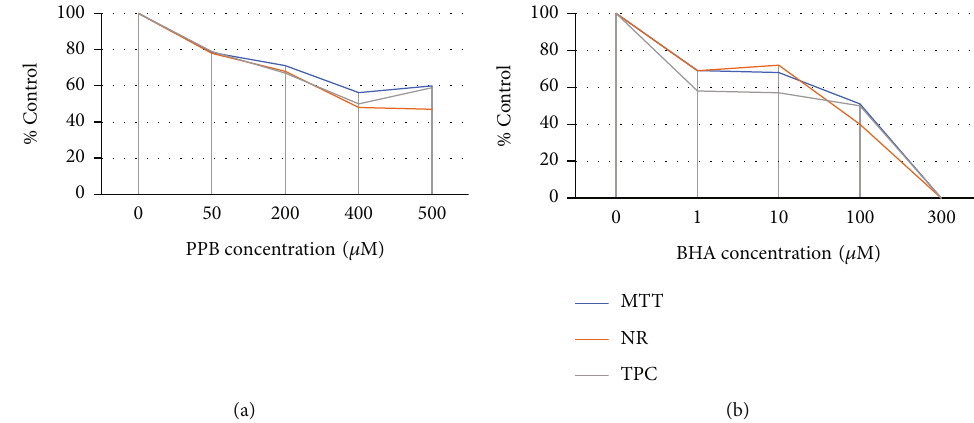
Figure 3: MTT reduction tests, neutral red capture, and TPC after 24 hours of exposure to binary mixtures of BHA and PPB. (a) Binary pools are composed of 100 μ M BHA and a range of PPB concentrations (50-500 μ M). (b) Binary pools are composed of 500 μ M PPB and a range of BHA concentrations (1-300 μ M) (ANOVA, p = 0 : 065